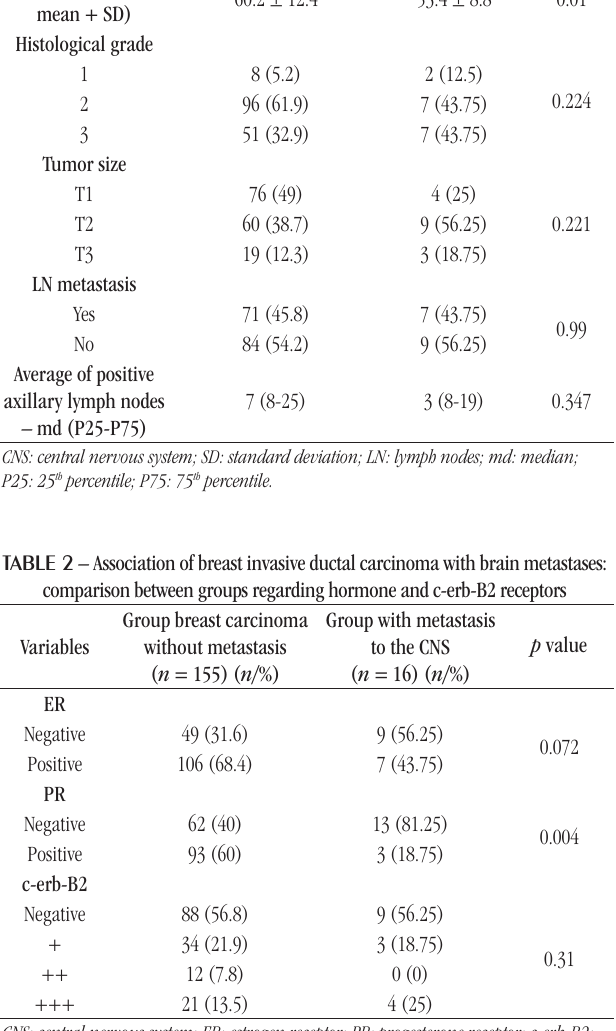
CNSm, grades 2 and 3 presented the same prevalence (43.75%).